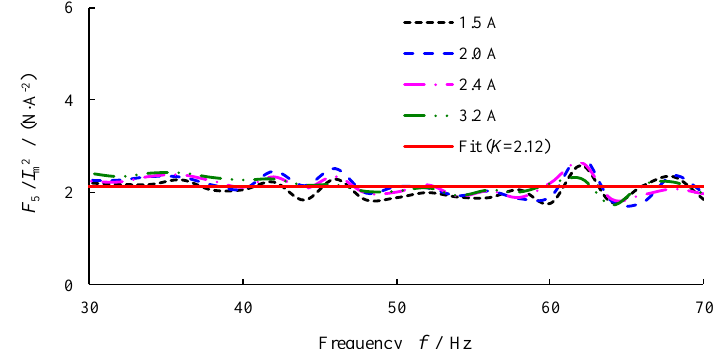
Figure 10. Experimental results and the fitted curve for F 5 ~ I 2 m , a